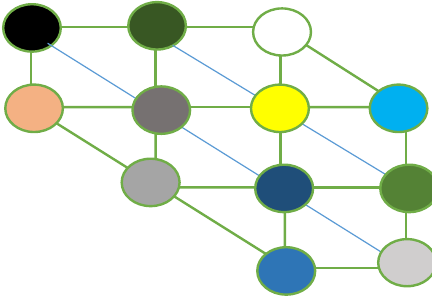
Figure 5. Clique for the L(2,1,1) coloring.